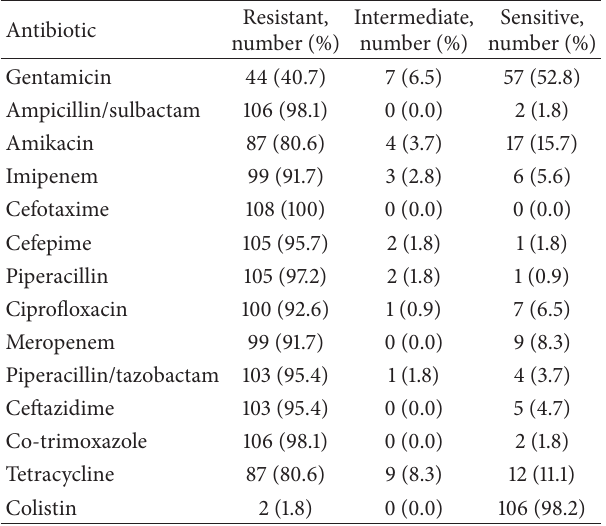
Table 1: Antimicrobial susceptibility test results of 108 isolated Acinetobacter baumannii .